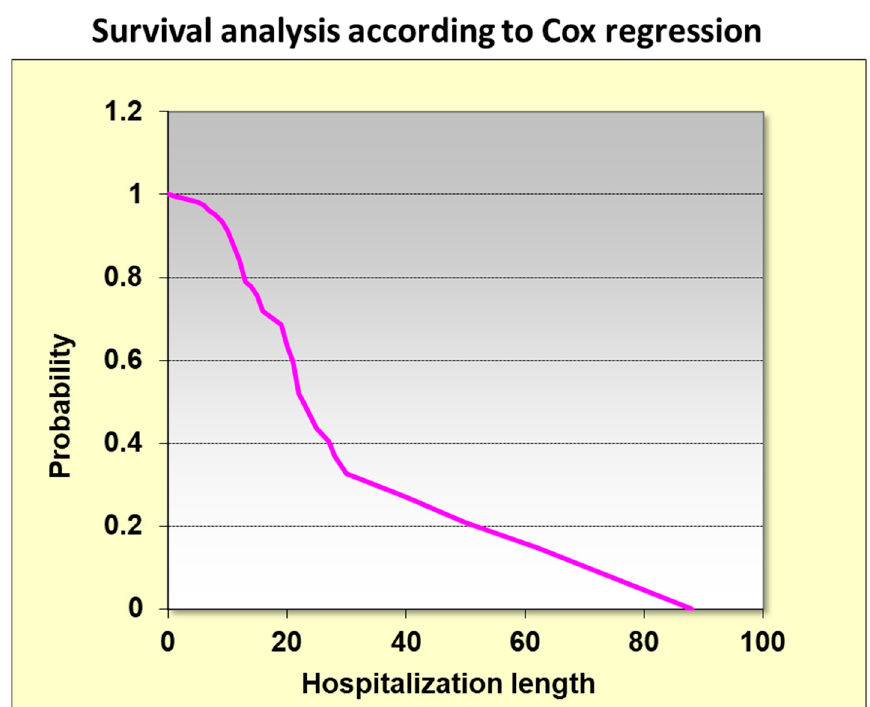
Figure 2. Survival analysis versus hospitalization length using Cox regression. 152